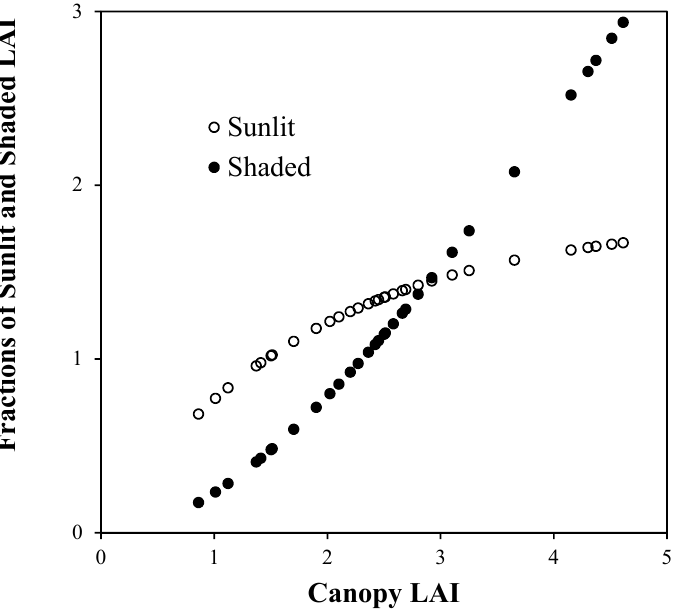
Figure 3. Quadratic relationship between fAPAR and canopy LAI at θ = 25°.